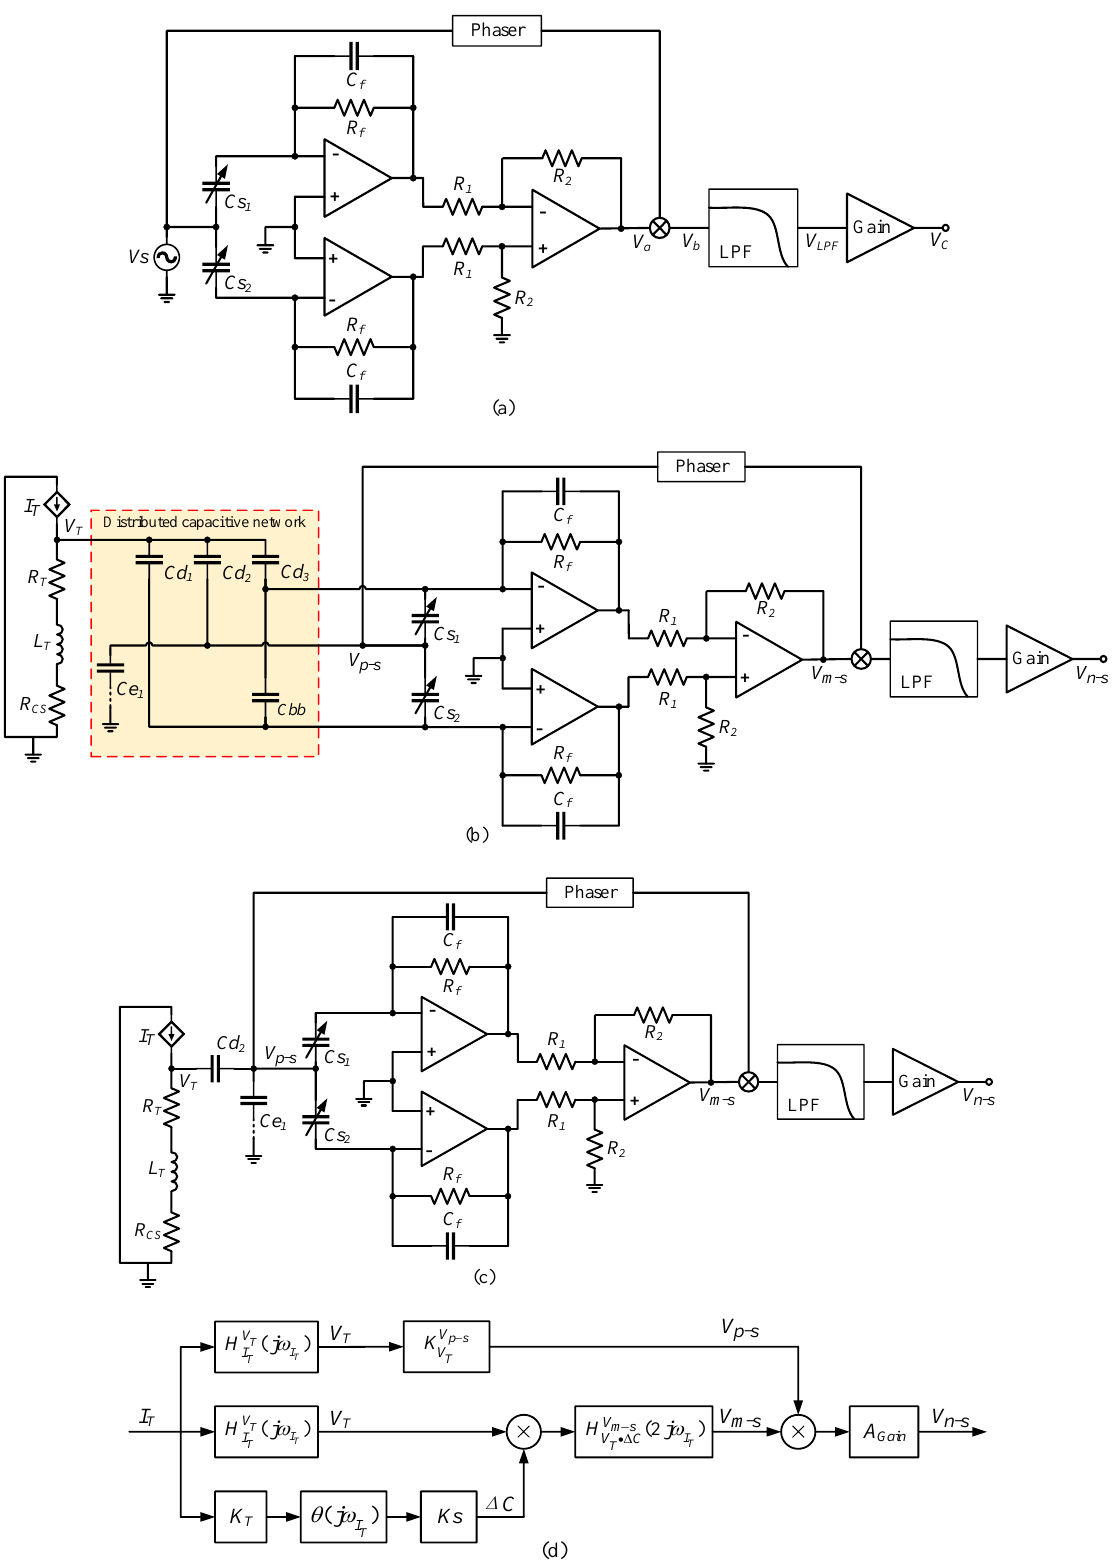
Figure 4. SCM detection circuit and its detection noise transfer path. ( a ) SCM detection circuit; ( b ) Detection noise transfer path composed of SCM detection circuit; ( c ) Simplified path of detection noise transfer formed by SCM detection circuit; ( d ) Structure of detection noise transfer system in SCM detection